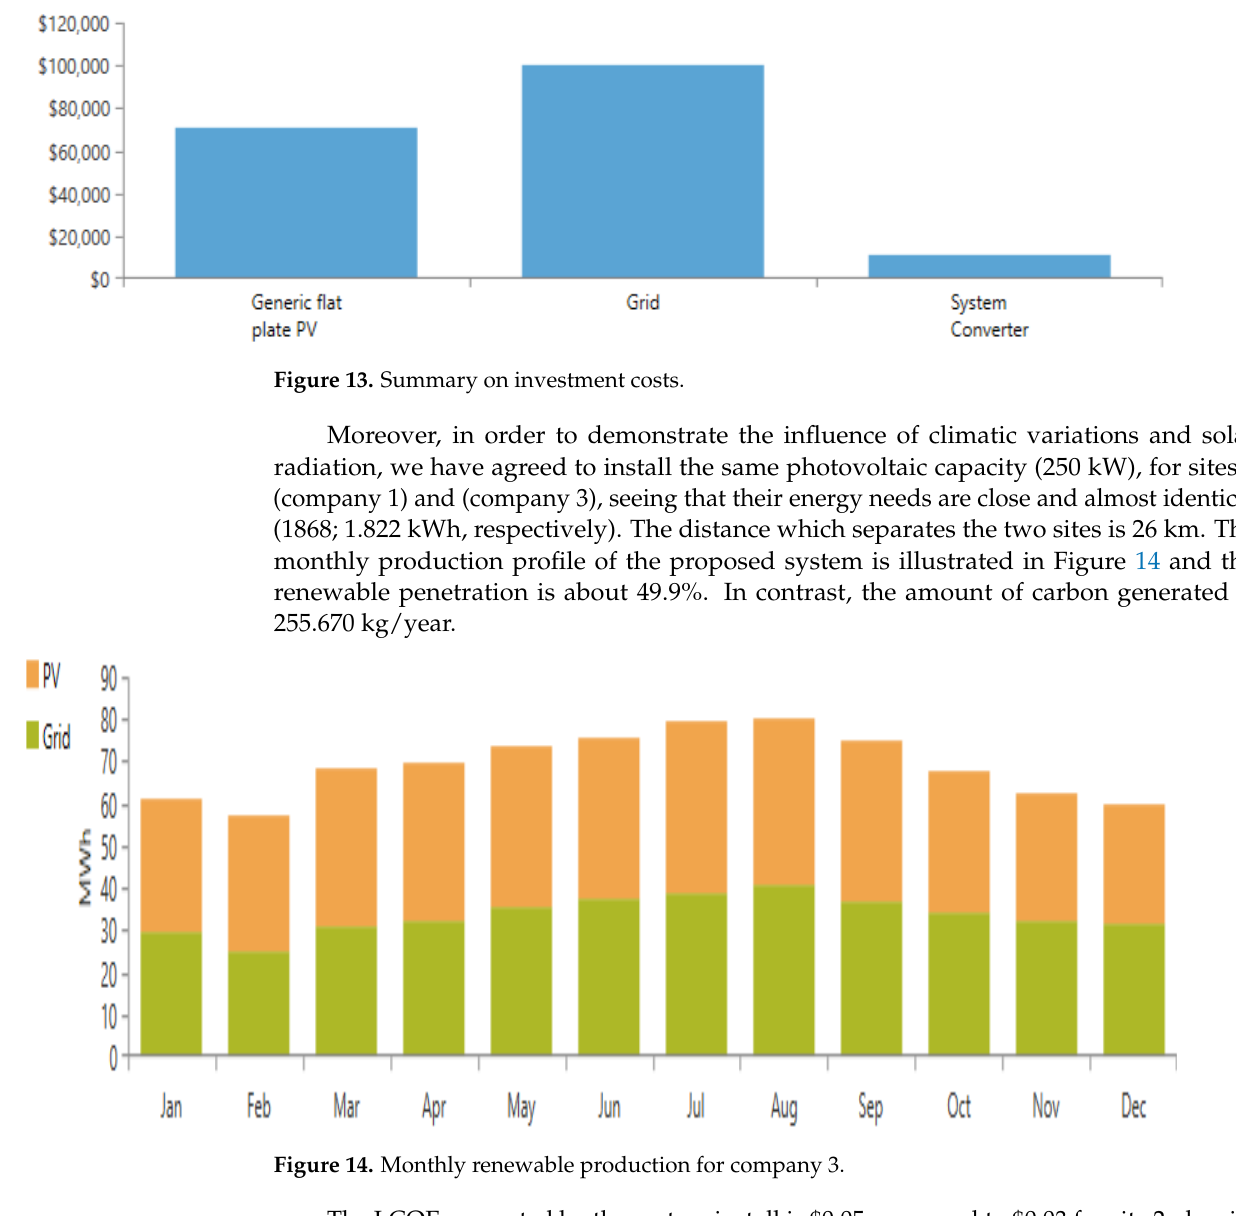
Figure 15. Energy exchange with the grid for company 3. Figure 16. Summary of the system ’ s cash flow.